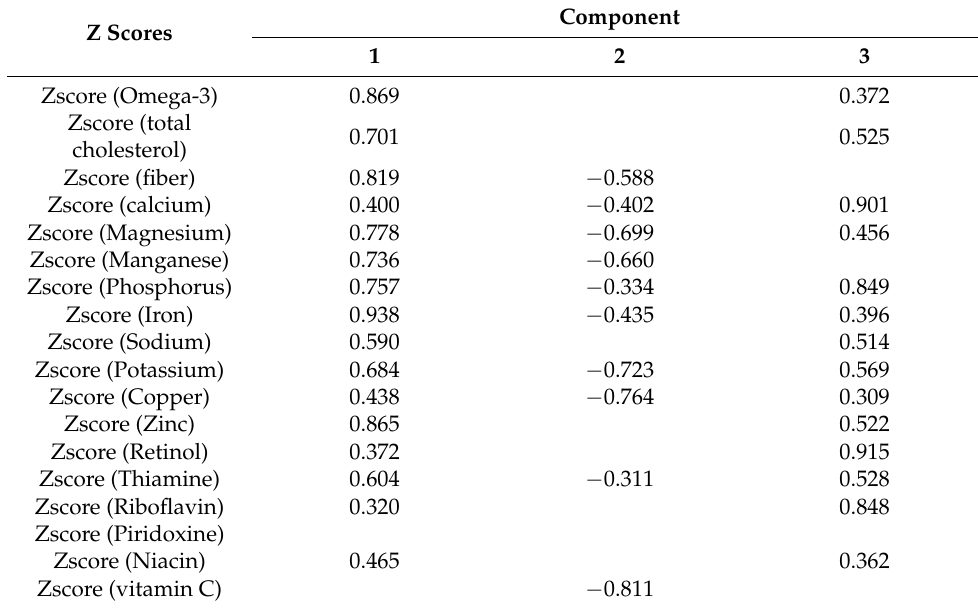
Figure 2. ( A ) Scree plot with the inflection point at component 3 used to determine the number of components to be retained. ( B ) Silhouette plot used to examine internal validity of the cluster solution. The X-axis shows the number of cases for each silhouette coefficient shown in the Y-axis. Table 2. Component loadings of micronutrient intake patterns obtained by principal component analysis with oblimin